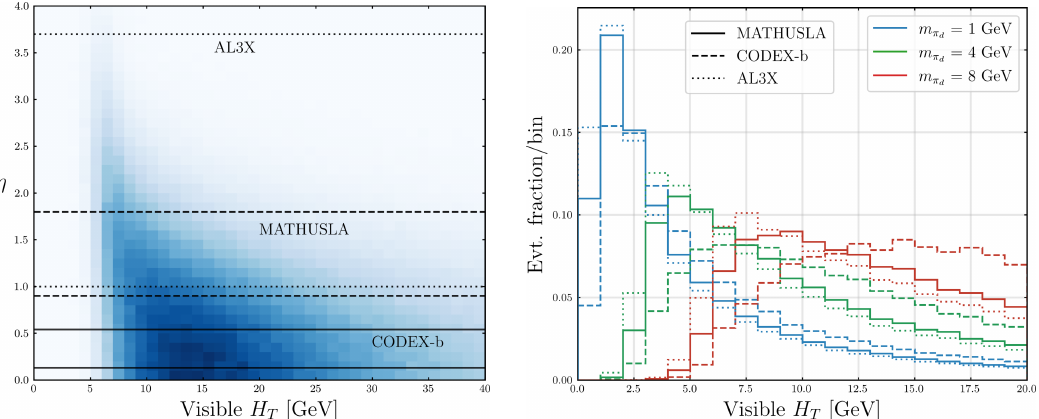
Figure 2 . The scalar p T sum of visible tracks ( H T ) resulting from decayed dark pions. Left: trans- verse LLP angular acceptances for visible H T using the m π for three different dark pion benchmarks: m π (intermediate spectrum in green), m π correspond to different η region associated with the detector’s acceptance, solid is MATHUSLA, dashed is CODEX-b, and dotted is